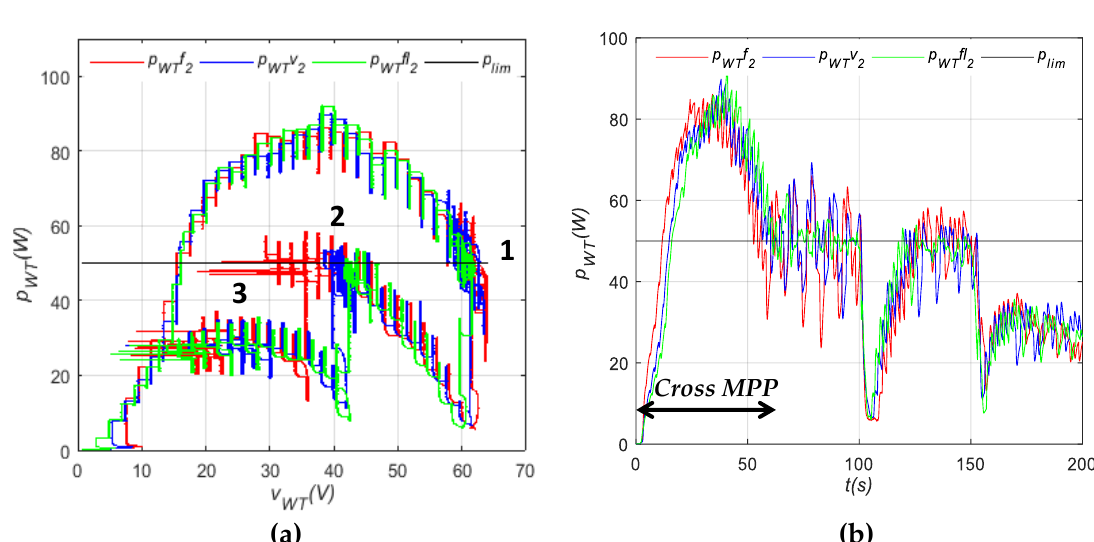
Figure 19. Drop in wind velocity: ( a ) p WT based on v WT ; ( b ) evolution of p WT in